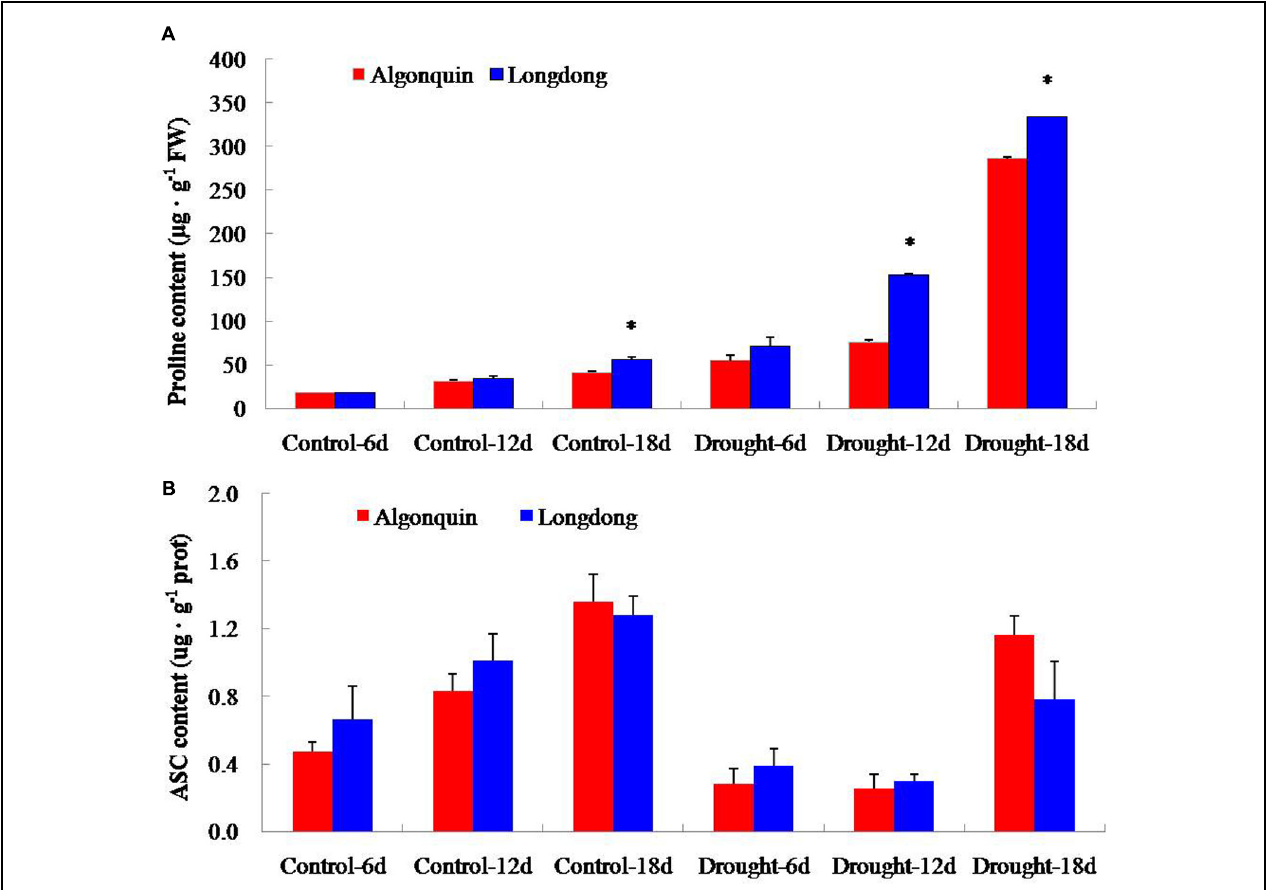
FIGURE 6 | The contents of proline and ASC of two varieties affected by drought. (A,B) The accumulation of proline and ASC of two alfalfa varieties during drought stress. The results shown are means ± SE ( n = 3). Asterisk symbols indicate significant differences from Algonquin at P < 0.05 (Student’s t -test).